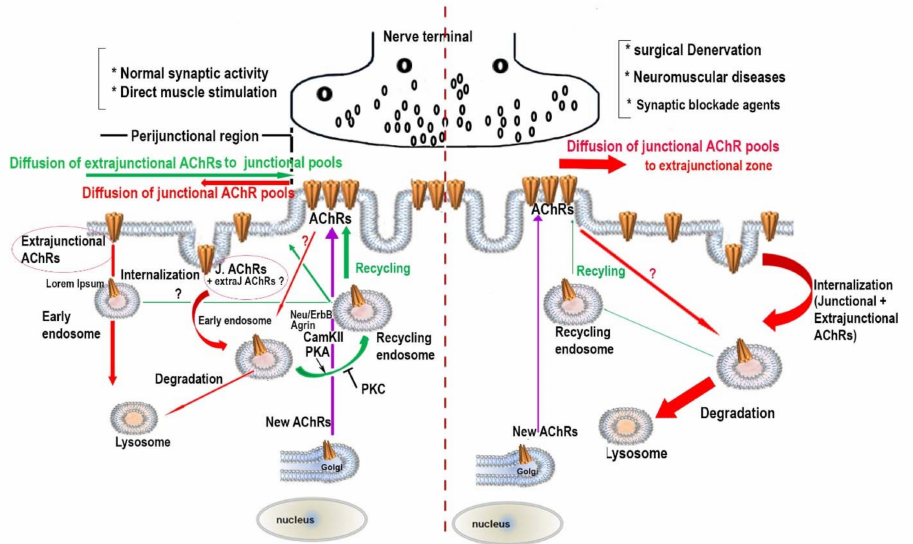
Figure 1. The metabolic stability of nAChRs at the functional and impaired peripheral cholinergic neuromuscular junction. A schematic diagram shows possible ways by which AChR pools (junctional and extrajunctional) are removed from and inserted into the neuromuscular junction under normal and pathological situations. Possible signaling molecules that mediate the recycling of AChRs are also